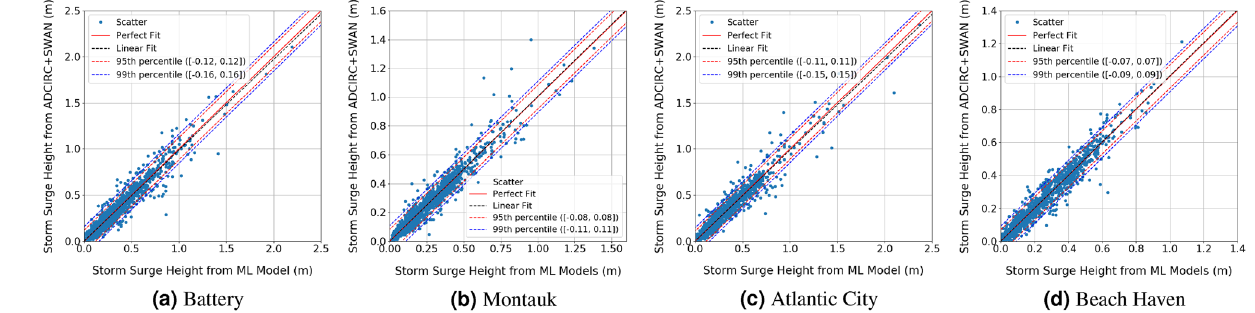
Figure 5. Scatter plots between the peak storm surge height calculated using the high-fidelity ADCIRC + SWAN simulations and those predicted from ML models at the four study